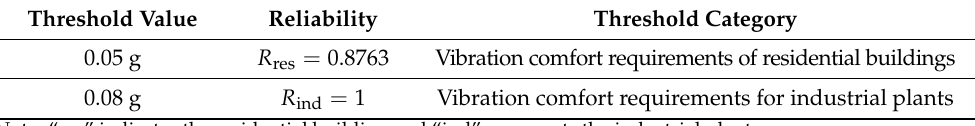
Table 2. Vibration comfort level reliability of the tunnel